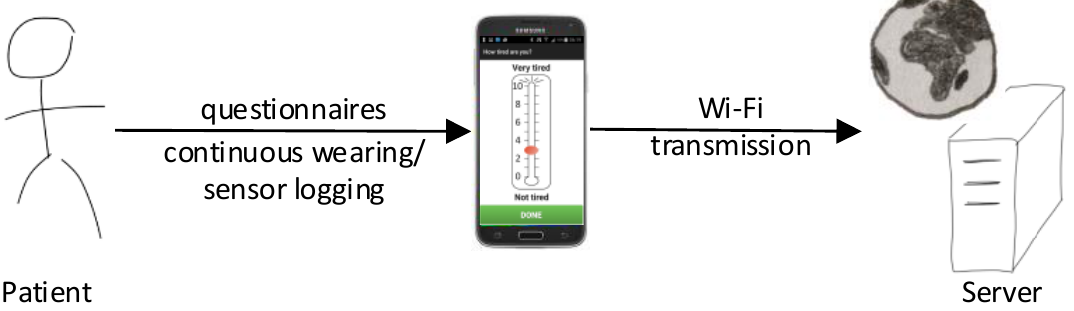
Figure 1. Monitoring system comprising of a smartphone with the activity monitoring app installed and a data receiving web-server.